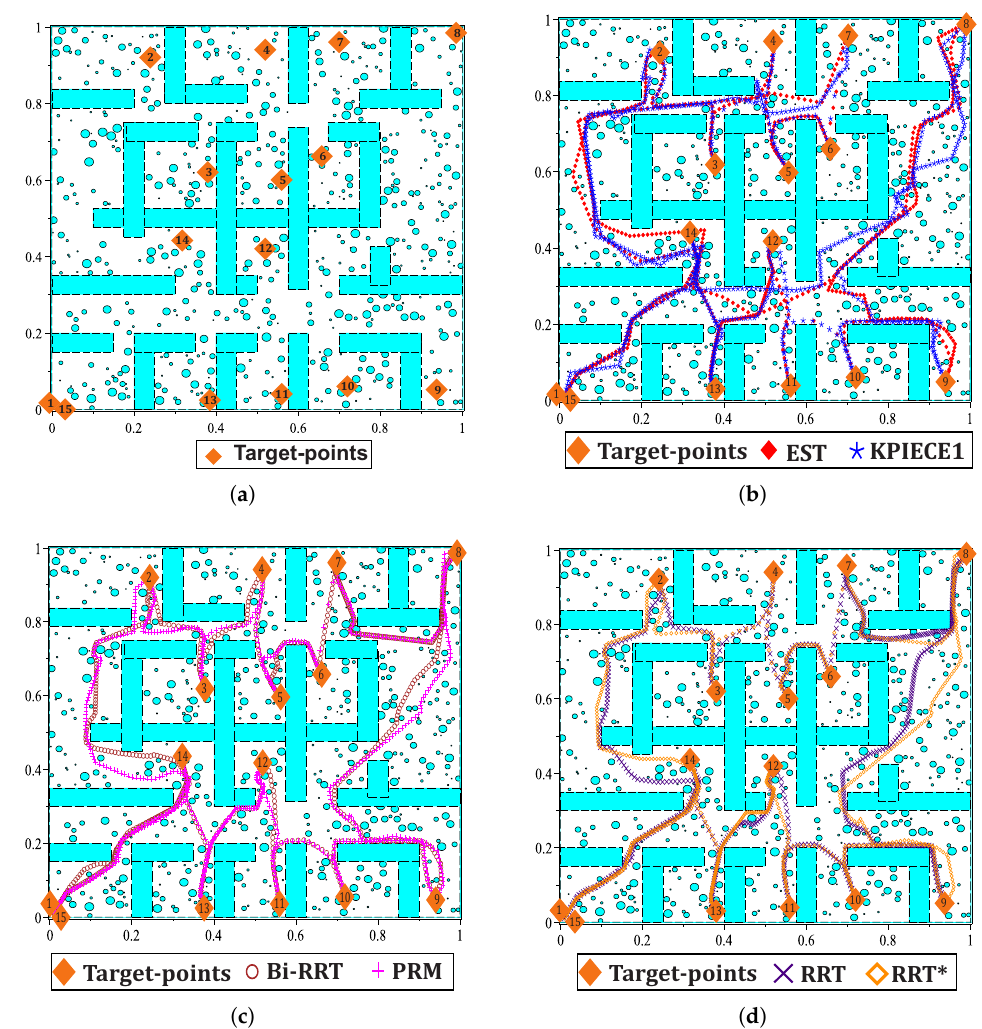
Figure 25. Multiple-target path problem solution using SBP algorithms with point-to-point strategy. ( a ) Multiple-target point problem (case study 5). ( b ) Multiple-target path using EST and KPIECE1. ( c ) Multiple-target path using RRTConnect and PRM. ( d ) Multiple-target path using RRT and